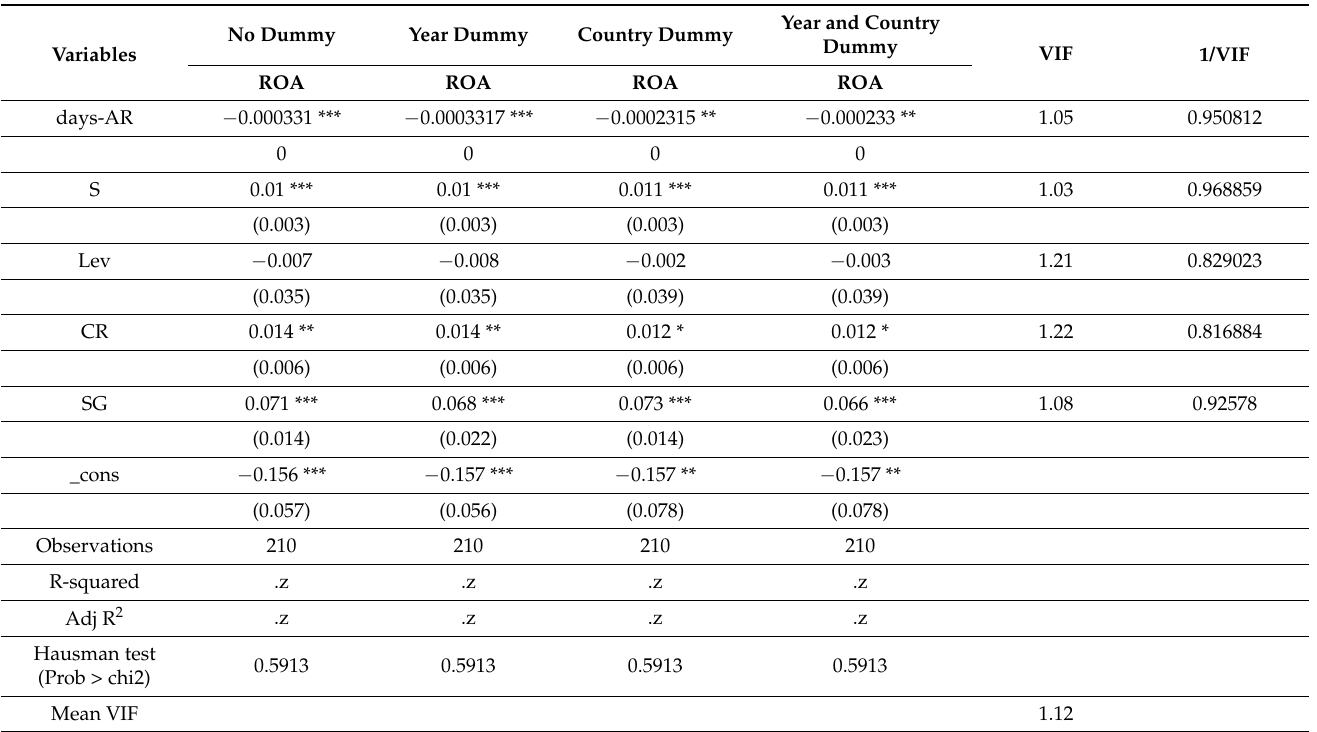
Table 7. Results of the random effects of days-AR on ROA, as per panel regression (pandemic period, 2020–2021).